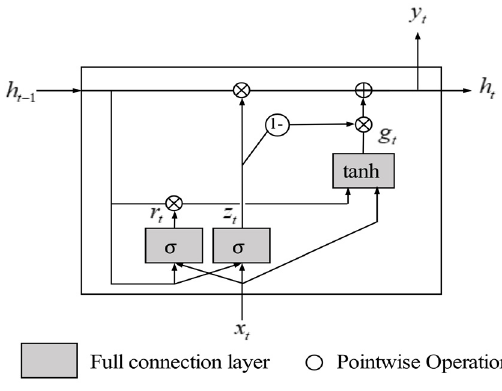
Figure 11. A GRU unit.